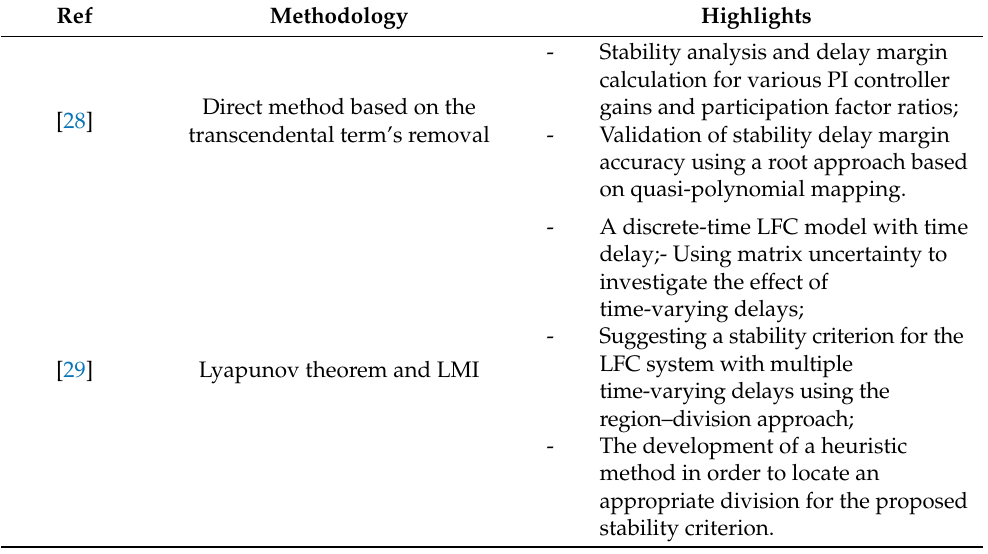
Table 1. A summary of the literature concerning stability studies of LFC systems with variable